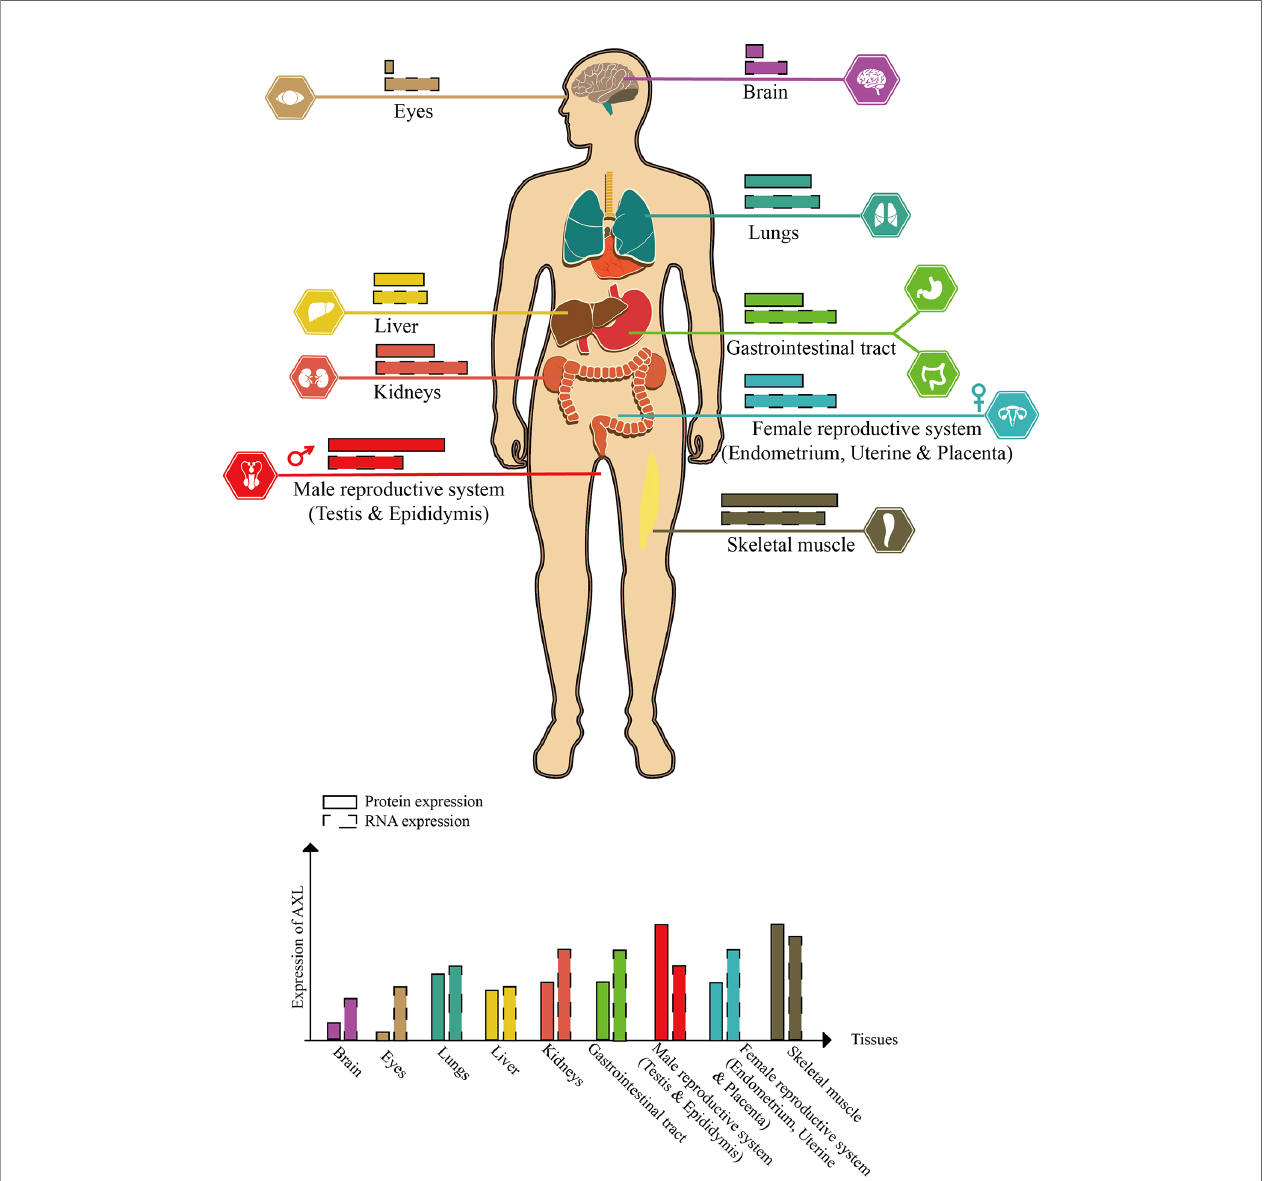
FIGURE 2 | Schematic diagram of AXL expression in human tissues (this fi gure is adapted from the data of “ THE HUMAN PROTEIN ATLAS ” website. For speci fi c data, please refer to